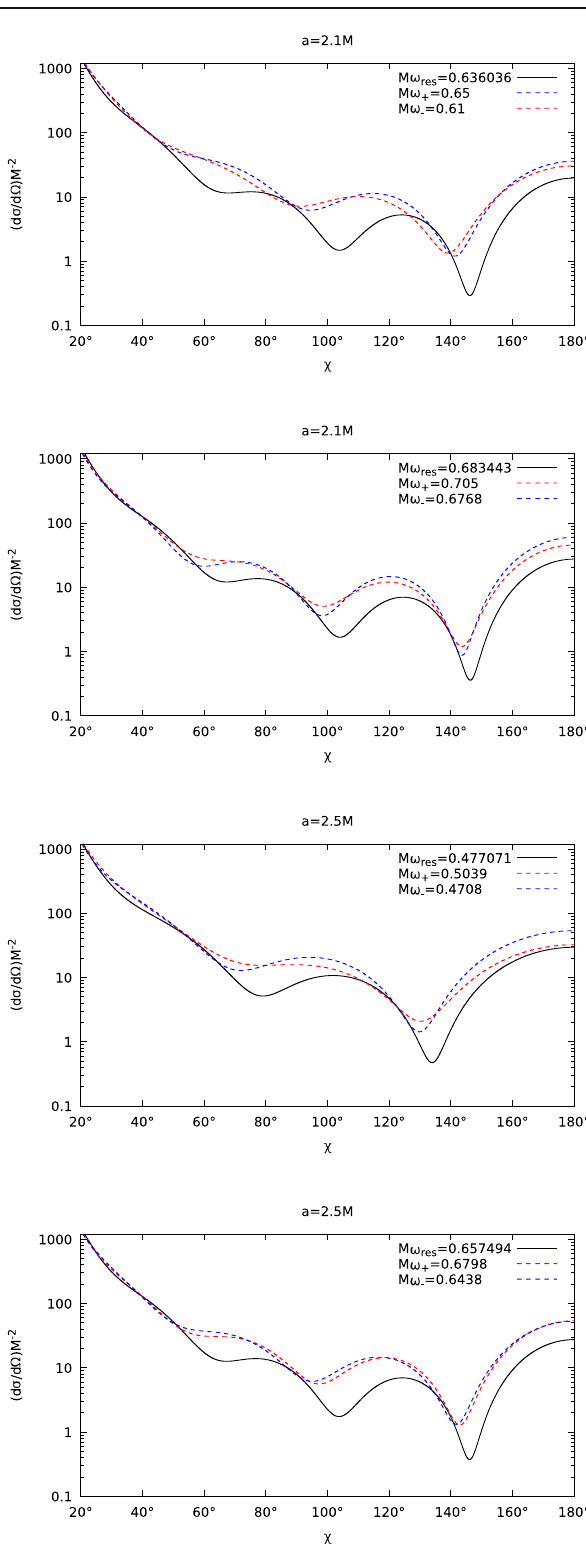
Fig. 7 The scalar differential scattering cross section of traversable wormholes, described by the Simpson–Visser metric, for selected reso- nant frequencies ω res (solid lines). We also show the differential scatter- ing cross section for one frequency slightly larger ( ω + ) and one slightly smaller ( ω − ) than the resonant